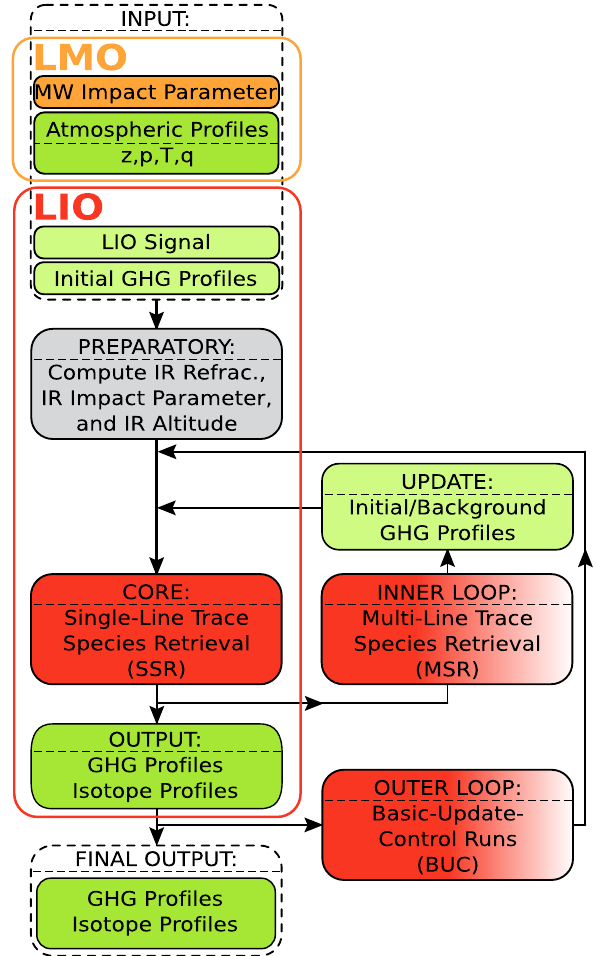
Fig. 3. Overview of the dynamic structure and flow of the LIO retrieval algorithm, highlighting its preparatory part, establishing IR refractivity, impact parameter, and altitude profiles (grey box), its core part, the single-line trace species retrieval SSR (red box), and its dynamical part of envelope loops over the SSR, consisting of the multi-line trace species retrieval (MSR) loop and the basic- update-control run (BUC) loop, respectively (gradient-red boxes); see the text in Sect. 3.2 for further